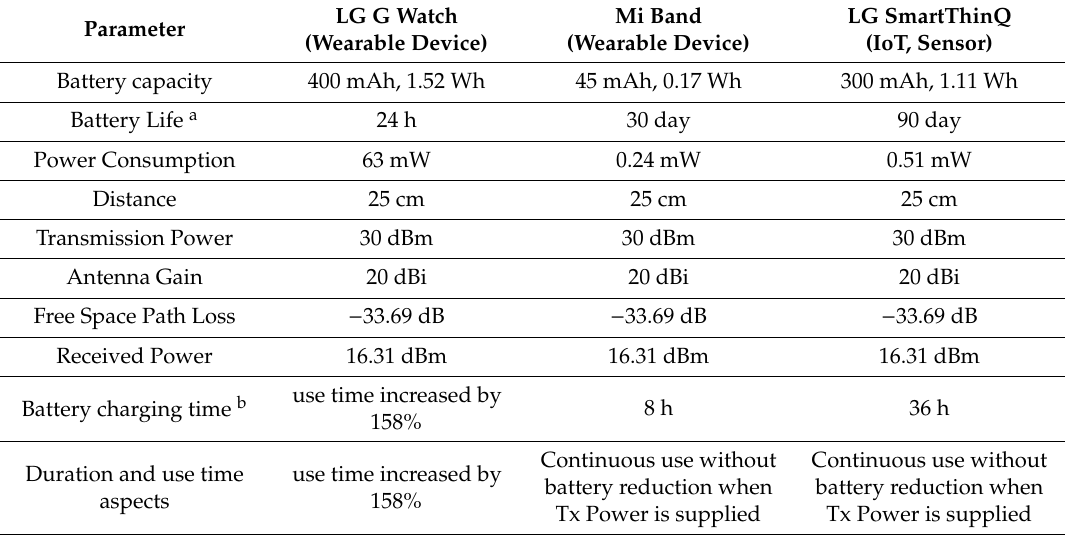
Table 3. Performance Summary of IoT / wearable Devices. Reprint with permission [4775431338148]; 2020,